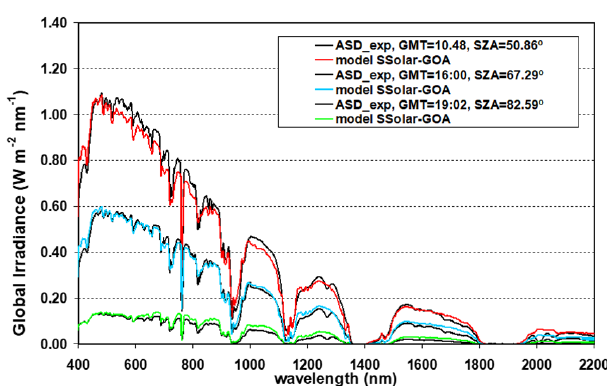
Figure 13. Comparison between the ASD measured and modelled SSolar-GOA global irradiance spectra covering the spectral range from 350 to 2200nm, taken on 29 July 2008 at Andenes (Andøya, Norway) at three SZAs. Input aerosol parameters are obtained from the values shown in Fig. 12 (see